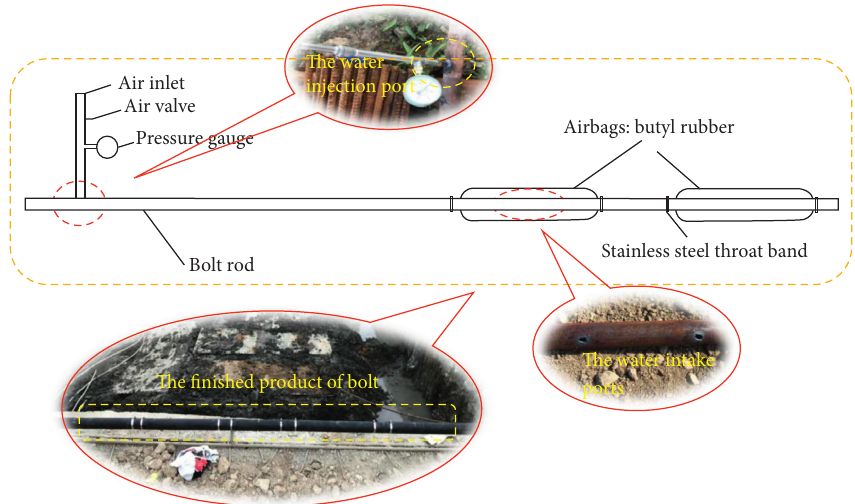
Figure 4: Product of the polycystic aeration bolt.